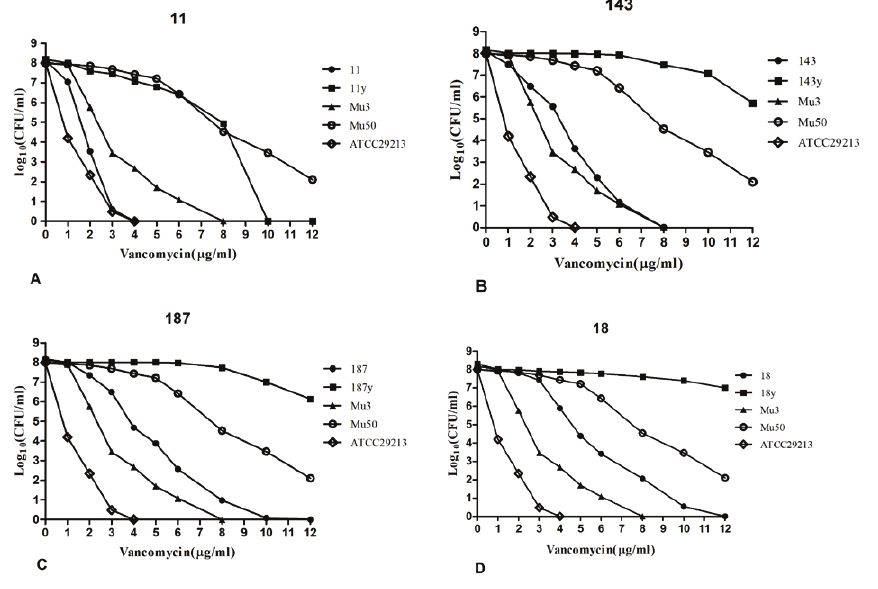
Figure 4: Population analysis of four pairs of parental strains and derivated strains. The hVISA strain Mu3 (ATCC 700698) and VISA strain Mu50 (ATCC 700699) were used as positive controls. The VSSA strain ATCC29213 was used as a negative